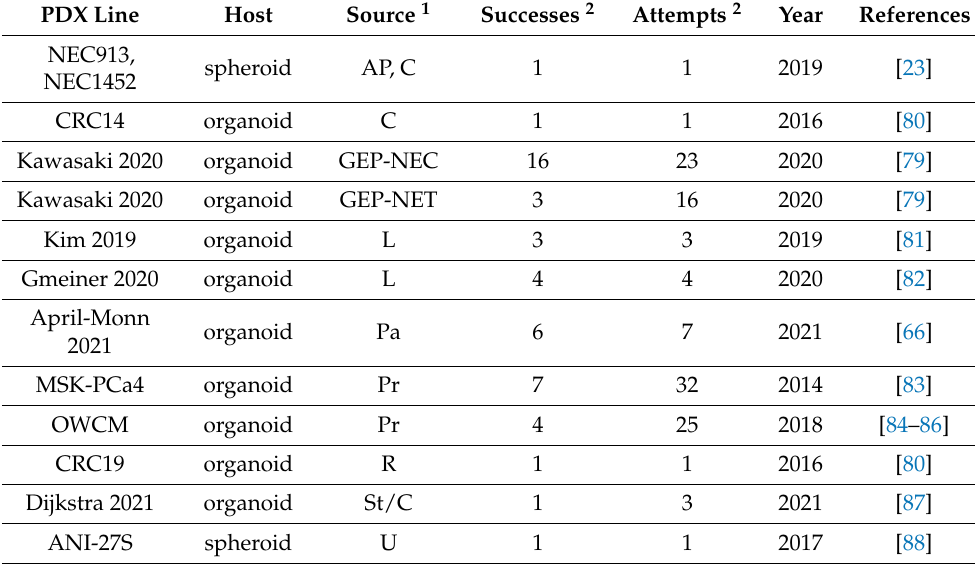
Table 2. Human neuroendocrine neoplasm-derived